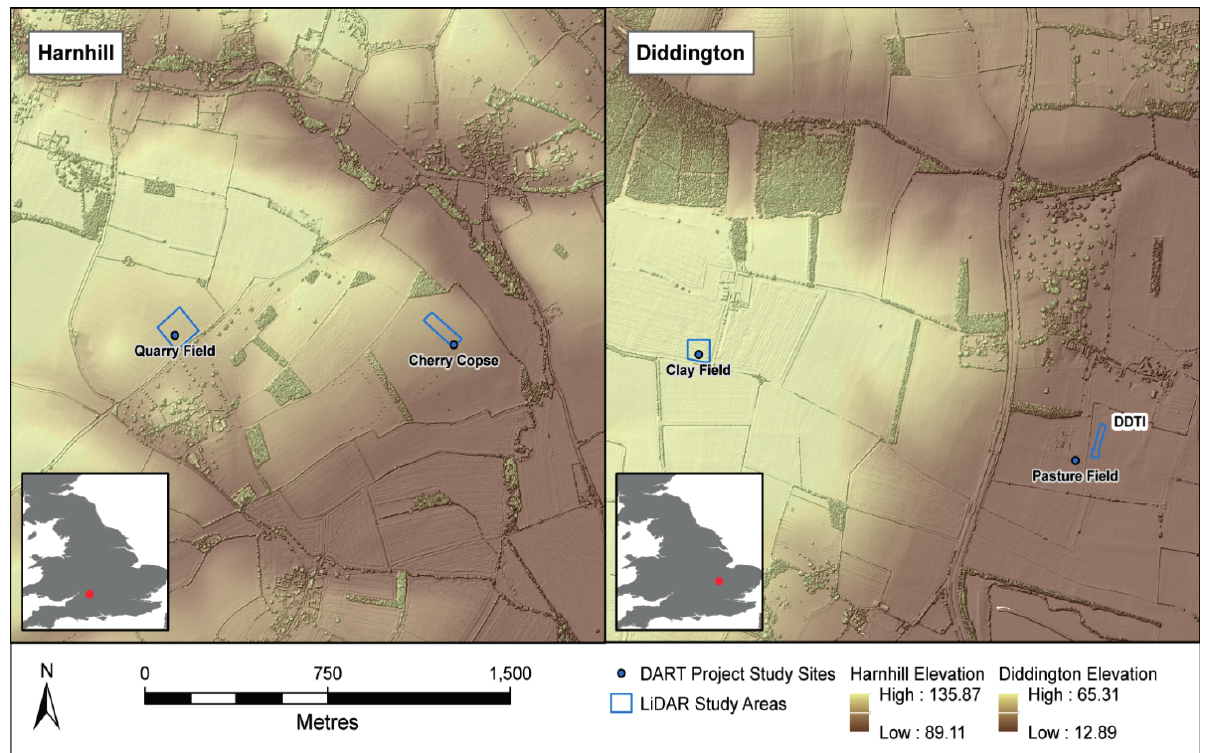
Figure 1. The two locations in southern England at which the study was undertaken, Harnhill and Diddington. At each location, two fields containing archaeological residues which do not exhibit any topographic expression were the focus of study using airborne LiDAR (illustrated by blue